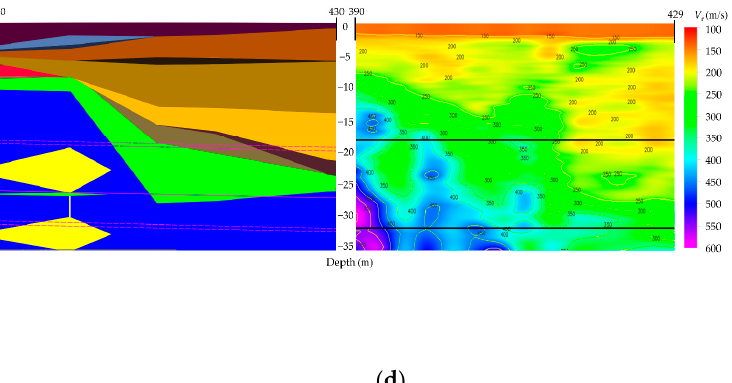
Figure 5. Comparison between microtremor exploration results and geological profile: ( a ) Rings 62 to 118; ( b ) Rings 121 to 217; ( c ) Rings 290 to 317; ( d ) Rings 390 to 429. In order to verify the reliability of microtremor geological exploration, an array with a radius of 2 m was set up at the position of holes ZK082, ZK085, ZK086, and ZK093 along the tunnel. The comparison between the geological results measured by borehole and the results obtained by microtremor exploration is shown in Figure 6. The figure also shows the change in geological wave velocity obtained by microtremor exploration. It can be seen tained by microtremor exploration in this study is highly consistent with the analysis data of the drill core, which can further verify the reliability of this method.